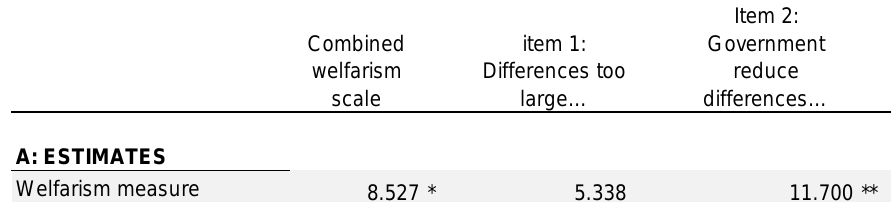
Figure A5. Effects on attitudes toward income redistribution. Main model using the two-item welfarism scale and estimates using each component item separately give equivalent results. Standaized corfficients from multilevel regression estimates for 30 nations, 1987–2009.